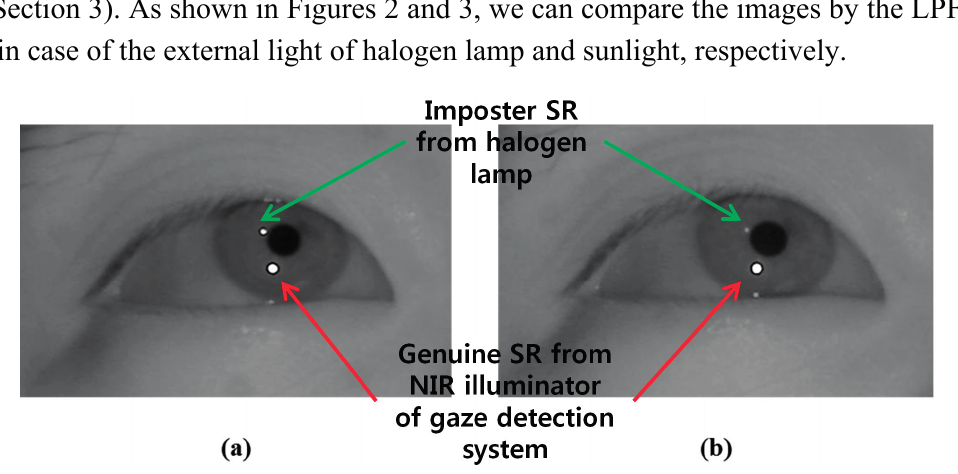
Figure 2. Eye region image under the illumination of halogen lamp ( a ) using LPF ( b ) using